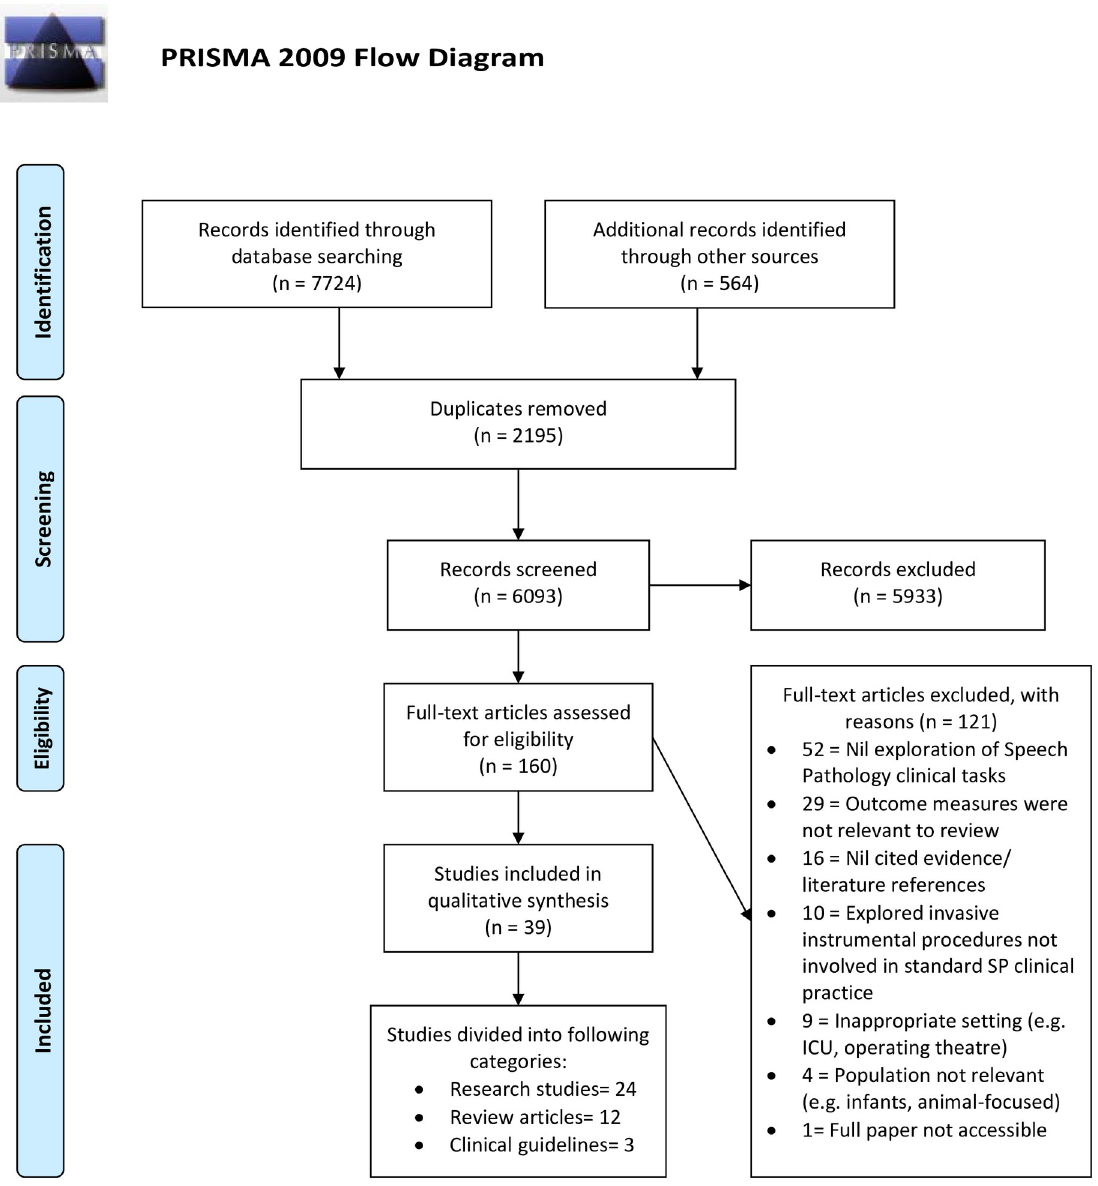
Fig 1. PRISMA flowchart of study inclusions and exclusions. From : Moher D, Liberati A, Tetzlaff J, Altman DG, The PRISMA Group (2009). P referred R eporting I tems for S ystematic Reviews and M eta- A nalyes: The PRISMA Statement. PLoS Med 6(7): e1000097. doi: 10. 1371/journal.pmed1000097 For more information, visit